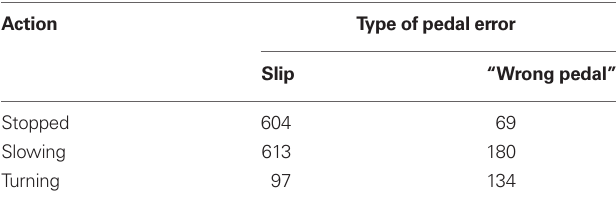
Table 3 | Pedal-error type as a function of driving circumstances.